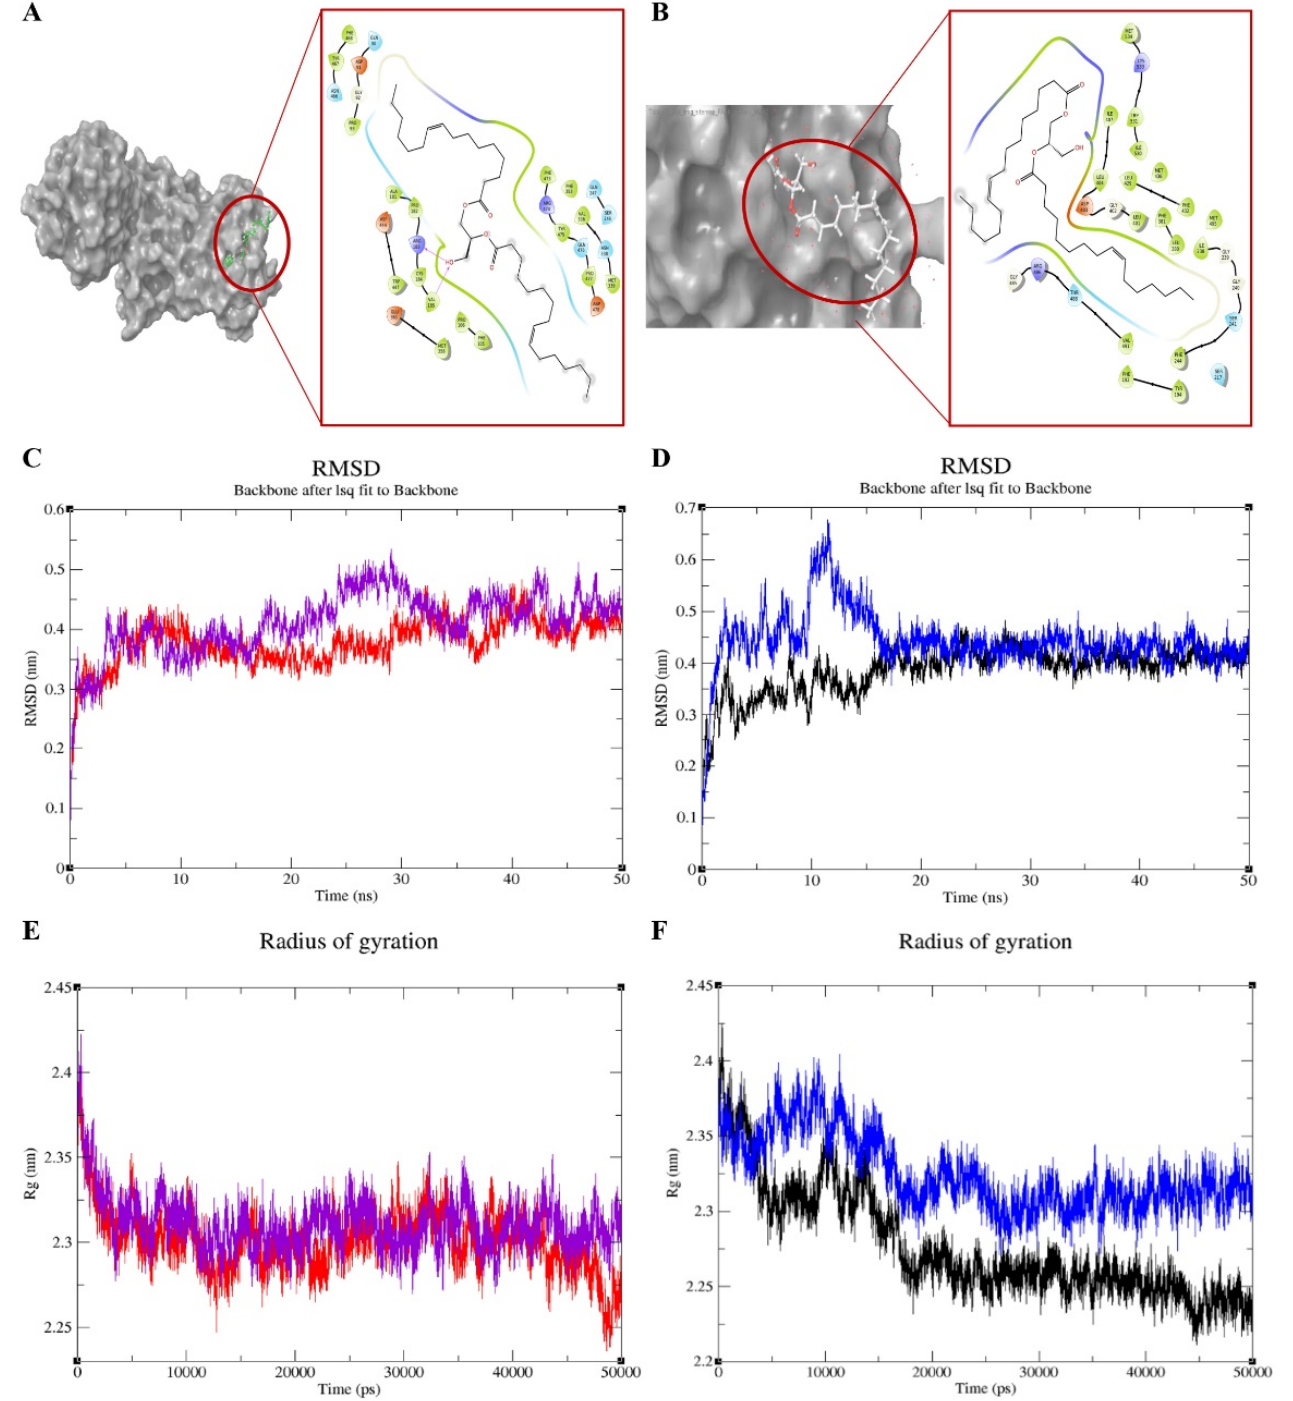
Figure 3. Molecular docking analysis ( A , B ), root mean square deviations (RMSD) ( C , D ), and radius of gyrations ( E , F ) for C2 -target [cannabinoid receptor 1 (CB1) and fatty acid amide hydrolase (FAAH1)] complex [color coding: purple—CB1; red—CB1 with C2 ; blue—FAAH1; black—FAAH1 with C2 ].